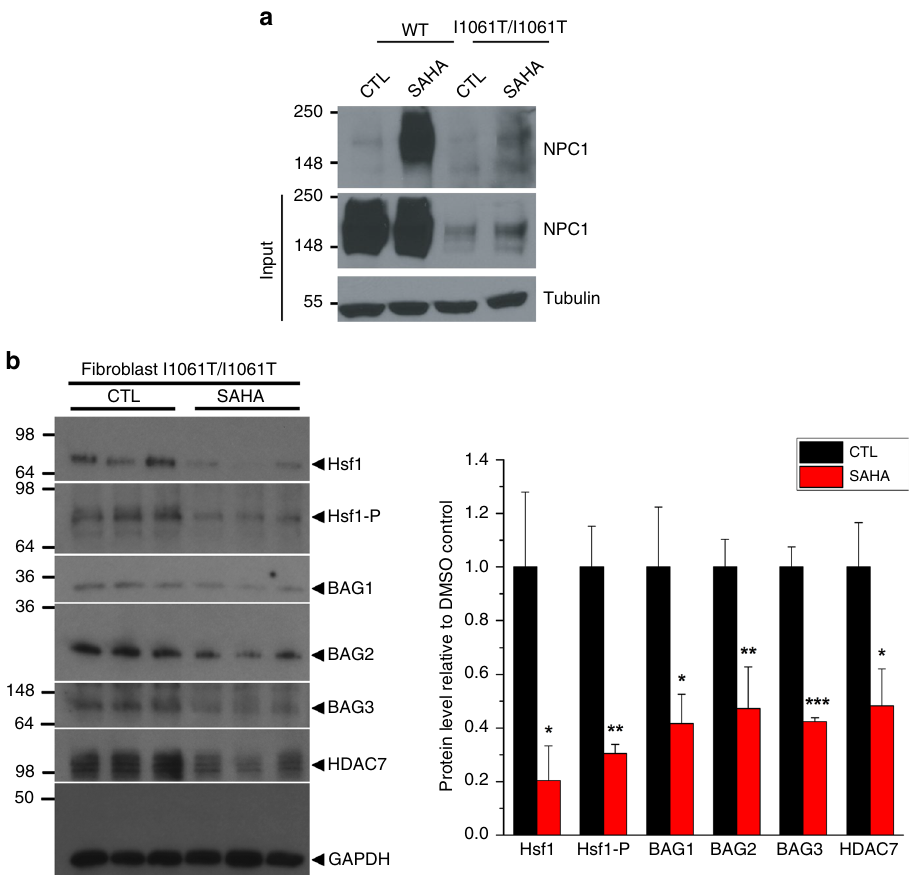
Fig. 5 Hyperacetylation of NPC1 and proteostasis impact by SAHA. a SAHA leads hyperacetylation of both WT and I1061T-NPC1. Cell lysate of WT or I1061T/I1061T patient fi broblast was immunoprecipitated by acetylated-lysine (AcK) antibody and then recognized by NPC1 antibody through western blot. b SAHA impacts the expression of proteostasis components. Immunoblot analysis of SAHA-treated (10 µ M for 48 h) I1061T/I1061T homozygous fi broblast (left panel) and quanti fi cation of total Hsf1, Hsf1 phosphorylated (Hsf1-P), BAG1, BAG2, BAG3, and HDAC7 (right panel) are shown. GAPDH was used as Western blot loading control. Data is presented as fold change to DMSO treatment (mean ± s.d., n = 3). P -values are indicated using student ’ s two tailed t -test (* p < 0.05, ** p <0.01, *** p